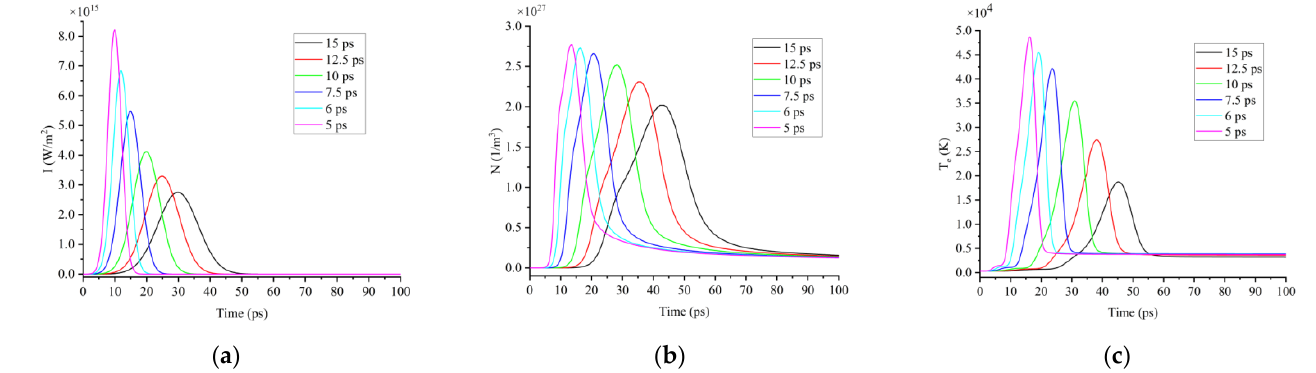
Figure 2. ( a ) Time distribution of laser power density; ( b ) variation characteristic of free electron concentration; ( c ) variation characteristic of electron temperature under the action of picosecond lasers with different pulse widths as 15 ps, 12.5 ps, 10 ps, 7.5 ps, 6 ps and 5 ps.